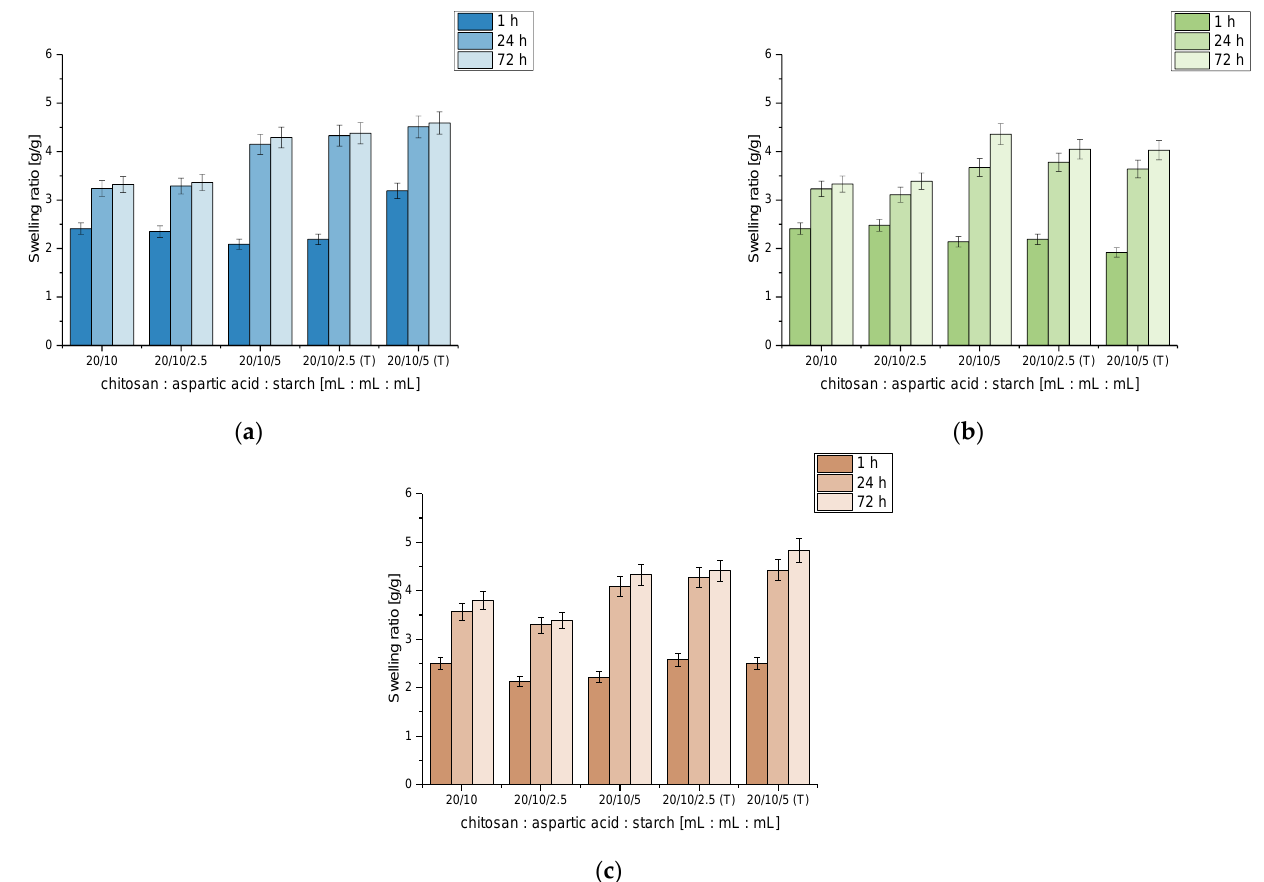
Figure 8. Results of sorption of hydrogels modified with starch in distilled water ( a ), Ringer liquid ( b ) and hemoglobin ( c ).